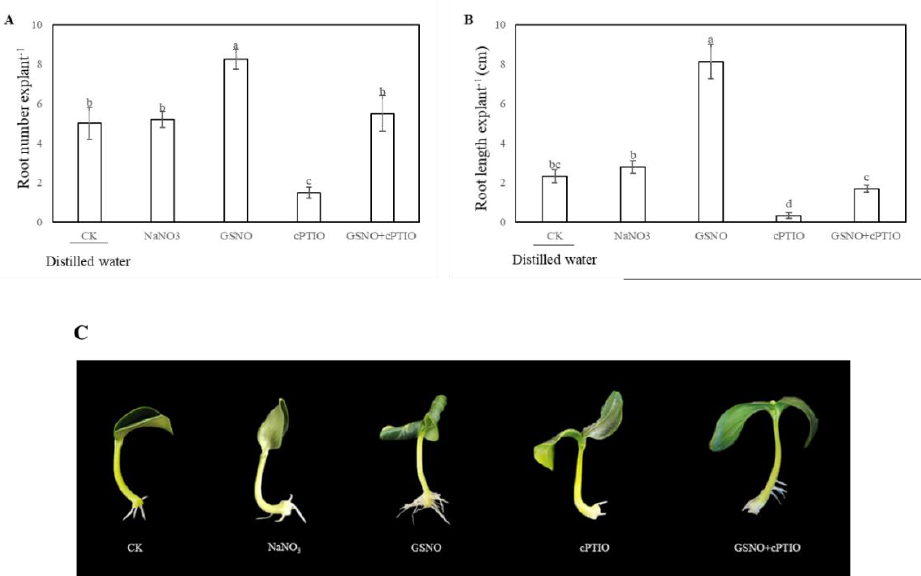
Figure 2. Effect of NO scavenger 2-(4-carboxy-2-phenyl)-4, 4, 5, 5-tetramethylimidazoline-1-oxyl-3-oxide (cPTIO) on adventitious root development in cucumber explants. The primary roots were removed from 5-day-old seedlings. Explants were then incubated for 5 days with distilled water (CK) or 100 μM sodium nitrate (NaNO 3 ), 50 μM GSNO, 200 μM cPTIO, or 50 μM GSNO + 200 μM cPTIO. The numbers ( A ) and root length ( B ) of adventitious roots were expressed as mean ± SE ( n = 3). Ten explants were used per replicate. Photographs ( C ) were taken after five days of the treatments indicated. Bars with different lowercase letters were significantly different by Duncan’s multiple range test ( p < 0.05). Bars with different lowercase letters were significantly different by Duncan’s multiple range test.